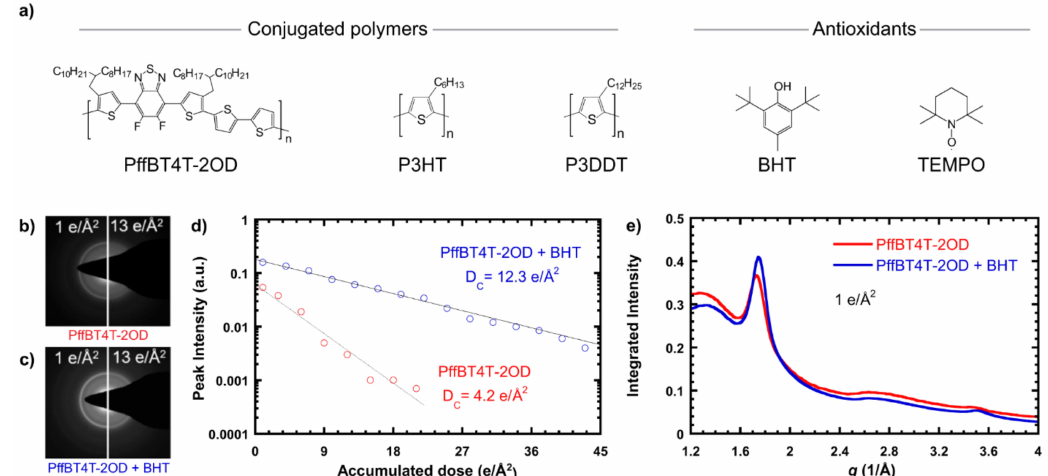
Figure 14. ( a ) Chemical structures of conjugated polymers and antioxidants used in the study of [115]. ( b ) Electron diffraction pattern of neat PffBT4T-2OD at low and high doses, showing loss of crystal structure after an accumulated dose of 13 e/Å 2 . ( c ) Electron diffraction pattern of PffBT4T-2OD + BHT at low and high doses, showing a partially preserved crystal structure at 13 e/Å 2 . ( d ) Background-subtracted peak intensity vs. accumulated dose for PffBT4T-2OD and PffBT4T-2OD + BHT, with exponential fits showing the persistence of the crystal structure at a higher dose with the addition of BHT. ( e ) Azimuthal integration of electron diffraction patterns of PffBT4T-2OD with and without BHT at a dose of 1 e/Å 2 , showing no change in the crystal structure. Reproduced from [115], under the terms of the Creative Commons CC BY license [18]. No changes have been made.